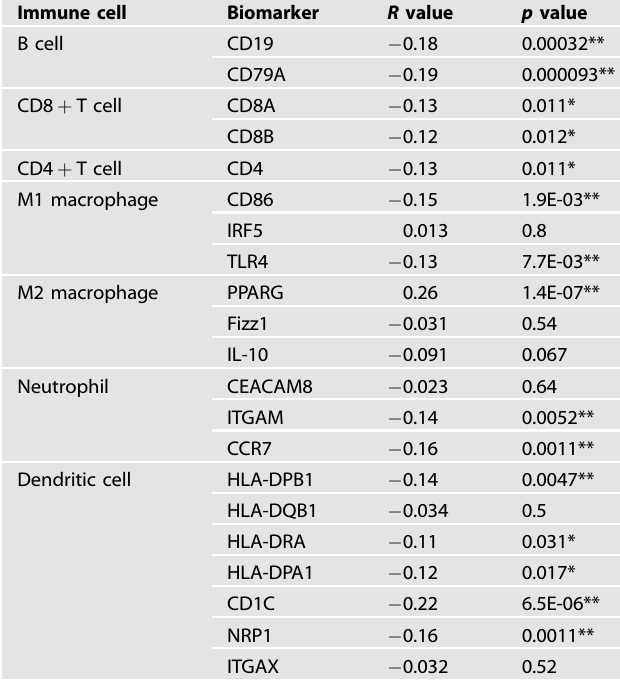
Table 1. Correlation analysis between GPR35 and biomarkers of immune cells in